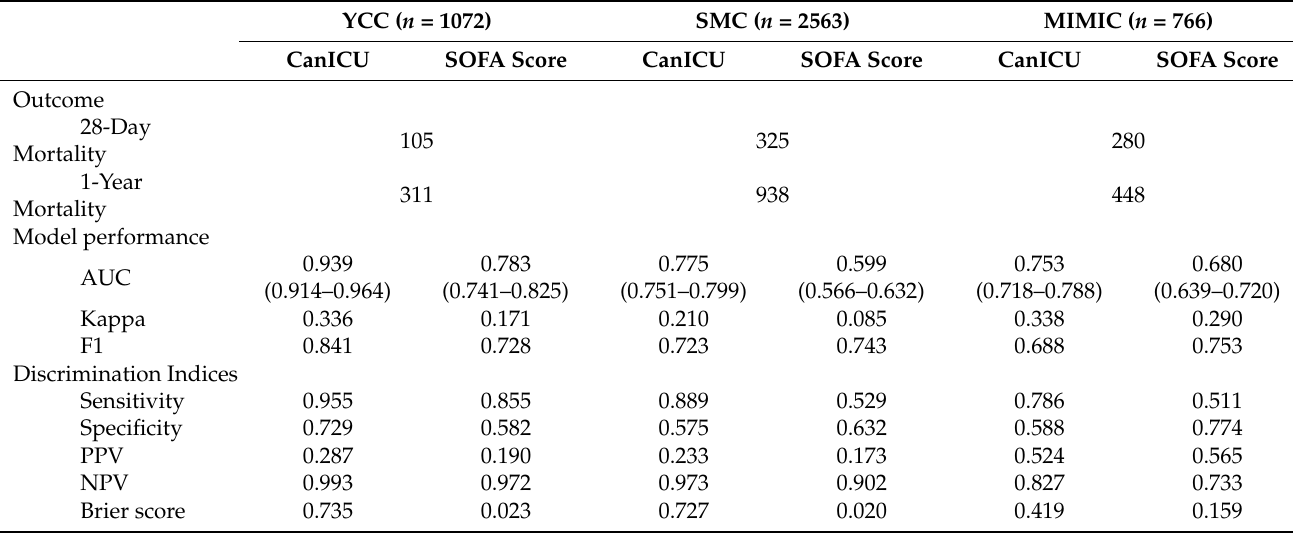
Table 2. Performance of CanICU to predict 28-day